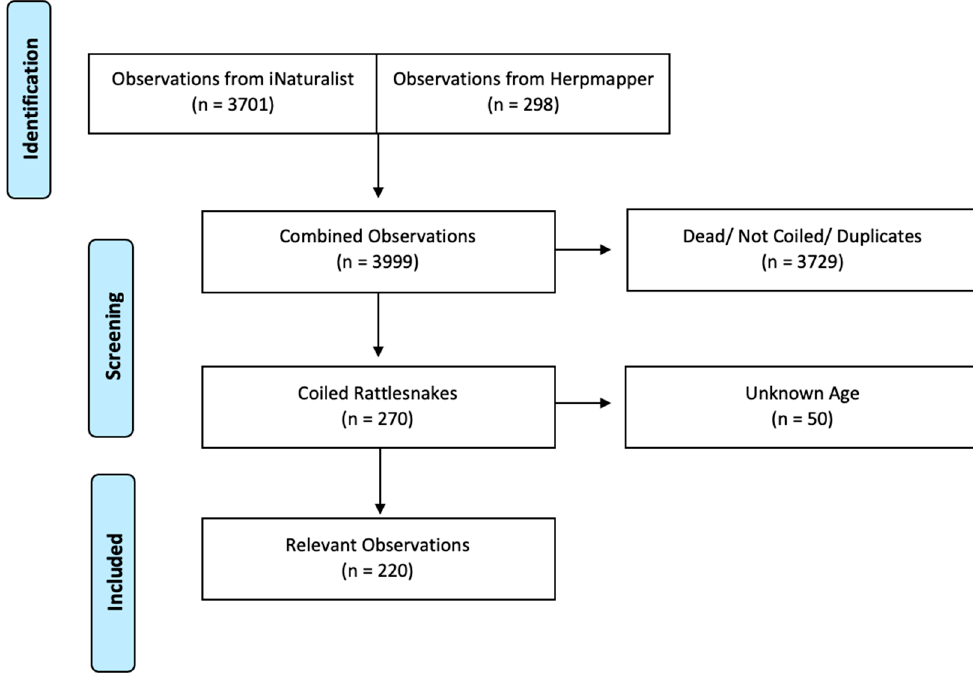
Figure 1. Filtering Process for Observations. Our community science searches yielded ~4000 observations. We disregarded any observations containing snakes that were dead, loosely coiled, elongated, duplicates, or found under cover boards. After filtering the observations, we were left with 220 observations of tightly coiled, hunting Southern Pacific Rattlesnakes.